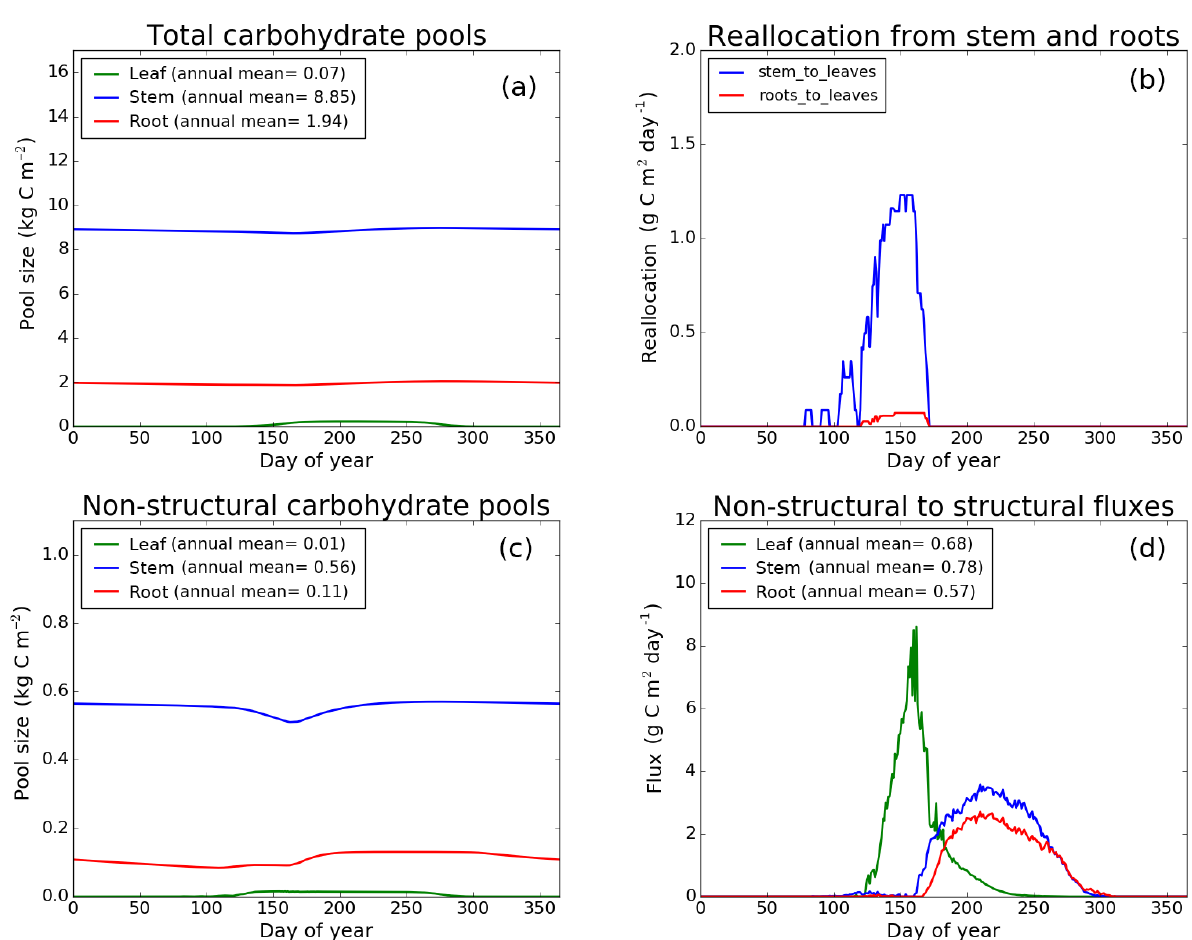
Figure 9. CLASS–CTEM (modified version) simulated values of total (a) and non-structural (c) carbohydrate pools (kgCm − 2 ). Panel (b) shows the reallocation of carbon from non-structural stem and root pools to leaves during leaf onset in spring and panel (d) shows the carbon flux from non-structural to structural pools for leaf, stem, and root components (gCm − 2 day − 1 ) for the US-UMB (University of Michigan Biological Reserve) FLUXNET site. The plots show mean daily values across all years for which the meteorological data were available after the model pools reached